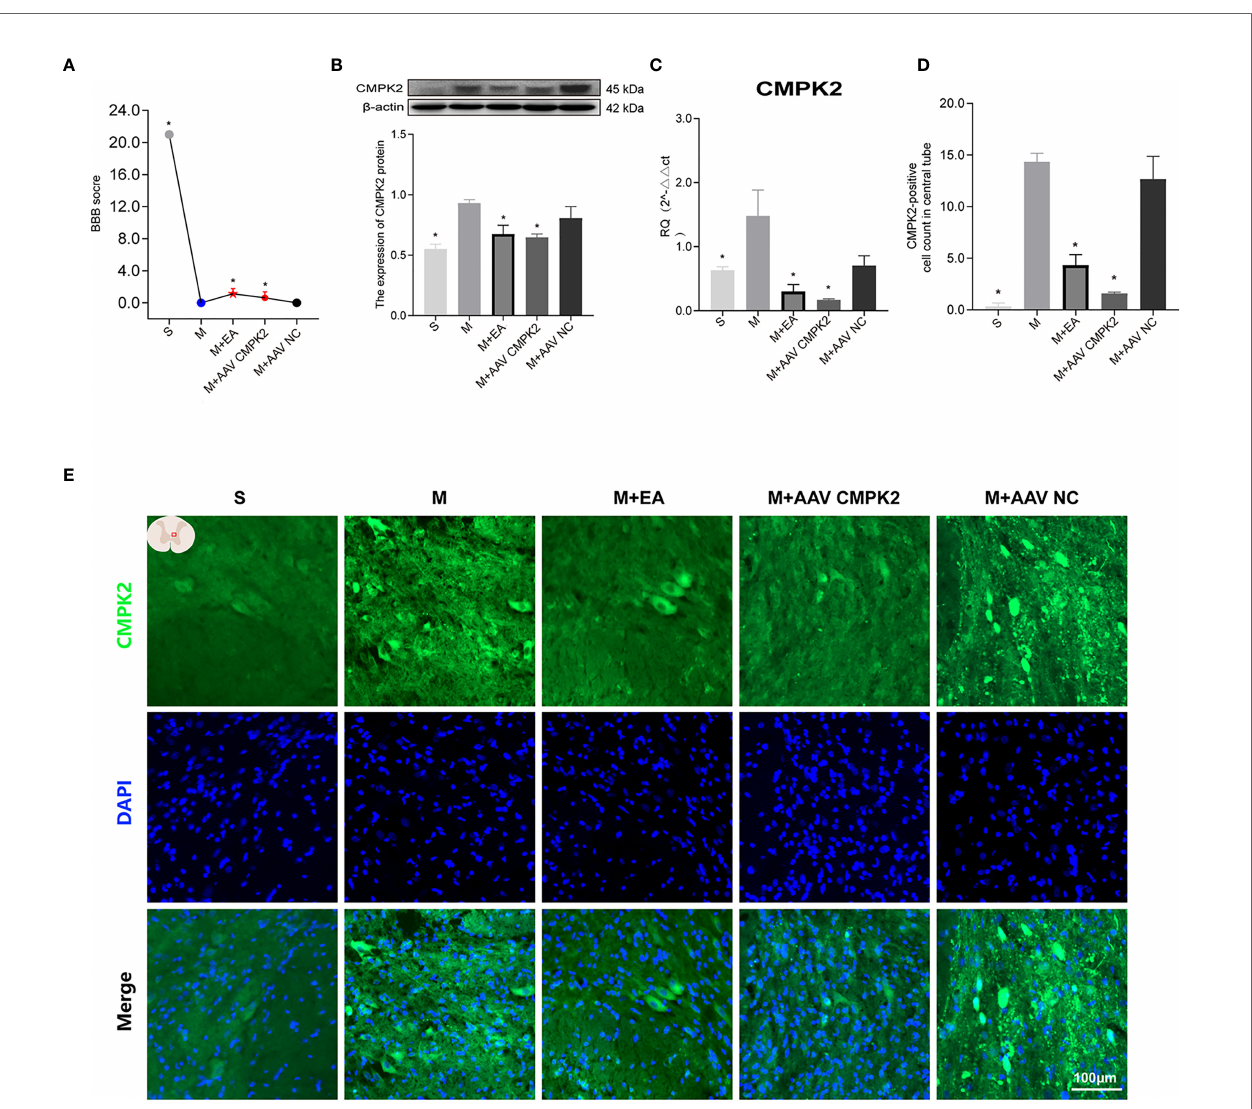
FIGURE 8 | Effect of EA on CMPK2 expression in spinal cords of rats following CMPK2 knockdown. (A) BBB scores of rats in the Sham, Model, M+EA, M+AAV CMPK2, and M+AAV NC groups. N = 8. *p < 0.05 compared with the model group. (B) Western blotting analysis of CMPK2 expression in spinal cord tissues of rats in the Sham, Model, M+EA, M+AAV CMPK2, and M+AAV NC groups. A representative Western blotting and semiquantitative analysis of CMPK2 are shown. N = 5 rats/group. * p < 0.05 compared with the model group; one-way anOVA was used for comparison. (C) Evaluation of CMPK2 gene expression using qPCR in the Sham, Model, M+EA, M+AAV CMPK2, and M+AAV NC groups 3 days after SCI. N = 5 rats/group. * p < 0.05 compared with the model group; one-way anOVA was used for comparison. (D) Quantitative analysis of CMPK2-positive cells. * p < 0.05 compared with the model group; one-way anOVA was used for comparison. N = 5 rats/group. (E) Immuno fl uorescence was used to detect the expression of CMPK2 around the central canal of the spinal gray matter of rats in the Sham, Model, M +EA, M+AAV CMPK2, and M+AAV NC groups. Number of CMPK2-positive cells (green fl uorescence) 3 days after SCI. DAPI (blue) co-staining was used to identify positive cells. All data are expressed as the mean ± SEM. EA, electroacupuncture; BBB, Basso – Beattie – Bresnahan; SCI, spinal cord